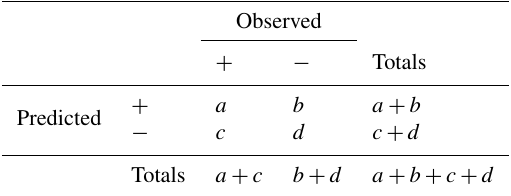
Table 2. Standard characterization of a 2 × 2 contingency